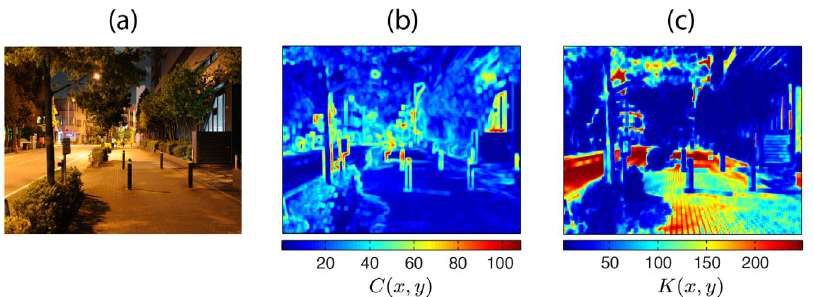
Figure 7. Contrast and kurtosis maps. (a) Original image. (b) Respective maps C and (c) K . Colormaps associated with RMS contrast and kurtosis values are shown below each